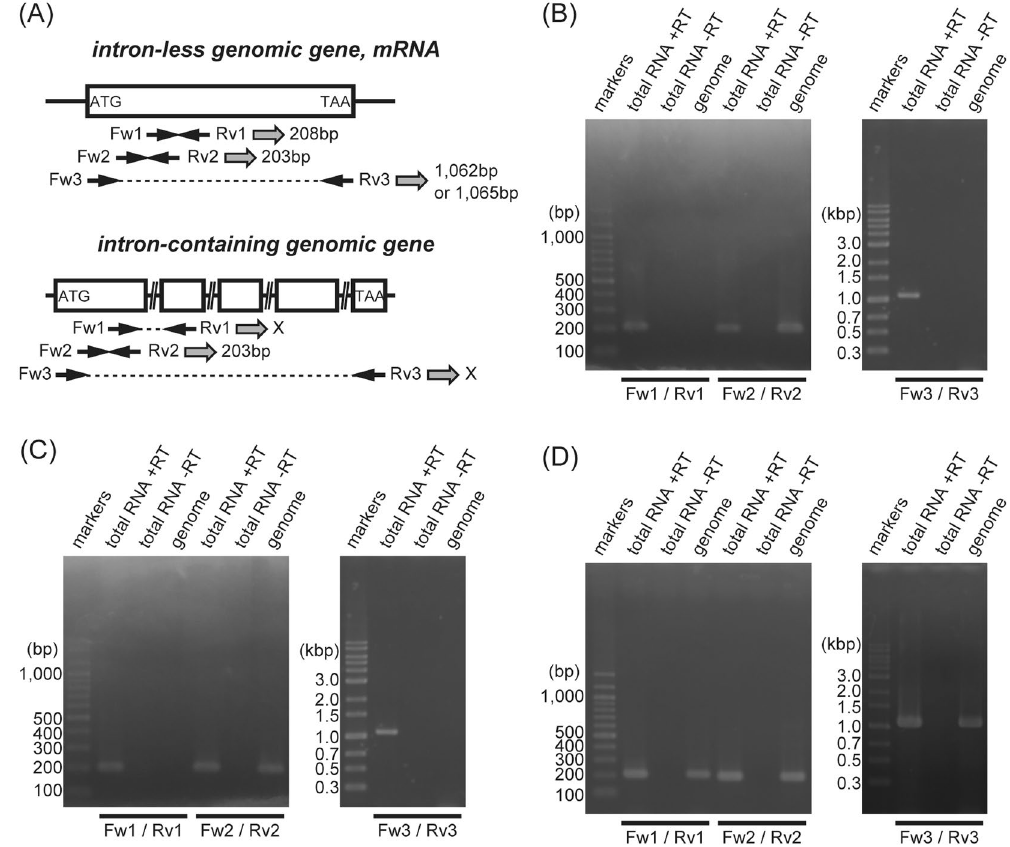
Figure 1. Genomic PCR and RT-PCR analyses of rhodopsin genes. ( A ) Positions of primers for genomic PCR and RT-PCR. We designed three pairs of primers (primers Fw1/Rv1, Fw2/Rv2 and Fw3/Rv3) based on rhodopsin mRNA sequences. Both primers Fw1 and Rv1 target the putative exons 1 and 2, whereas primer Fw2 and Rv2 target the putative exon1, respectively. Thus, if the rhodopsin gene has no introns, a band of around 200 bp can be amplified by the genomic PCR using both primer pairs. If the rhodopsin gene has introns, a band of around 200 bp can be amplified by the genomic PCR using primer pair Fw2/Rv2 but not using primer pair Fw1/Rv1. In addition, primers Fw3 and Rv3 target 5 ′ - and 3 ′ -end of a full-length coding region of the rhodopsin clone, respectively. Thus, if the rhodopsin gene has no introns, a band of around 1,060 bp can be amplified by the genomic PCR using this primer pair. If the rhodopsin gene has introns, a band of around 1,060 bp cannot be amplified by the genomic PCR using this primer pair. Sequences of PCR primers are shown in Table S1. ( B , C ) Genomic PCR and RT-PCR on gray bichir ( B ) and reedfish ( C ) rhodopsin. The genomic PCR amplified a band of around 200 bp using only primer pair Fw2/Rv2. It should be noted that RT-PCR on eye total RNA amplified a band of around 200 bp using primer pairs Fw1/Rv1 and Fw2/Rv2 and a band of around 1,060 bp using primer pair Fw3/Rv3. No corresponding bands in the “no reverse transcriptase” reaction confirmed that the band of RT-PCR is not attributed to contaminating genomic DNA. D. Genomic PCR and RT-PCR on Siberian sturgeon rhodopsin. The genomic PCR amplified a band of around 200 bp using primer pairs Fw1/Rv1 and Fw2/Rv2 and a band of around 1,060 bp using primer pair Fw3/Rv3. These bands were also amplified by RT-PCR on eye total RNA, not by “no reverse transcriptase”